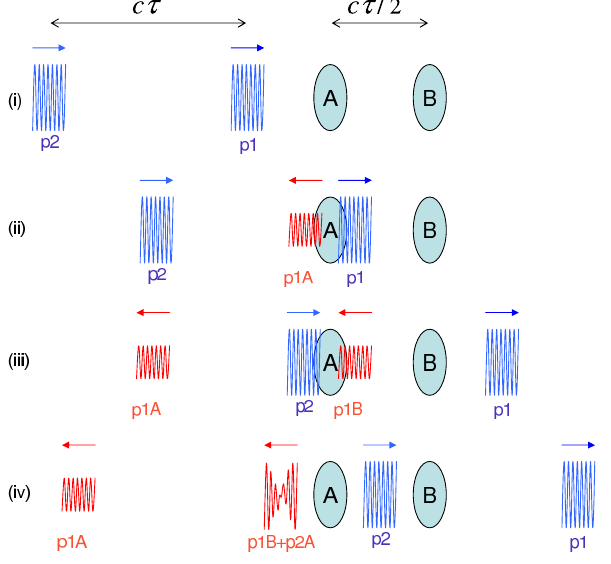
Fig. 2. Illustration of conditions for cross-range interference. Transmitter pulses are drawn in blue, reflected ones in red. Time increases from top to bottom.